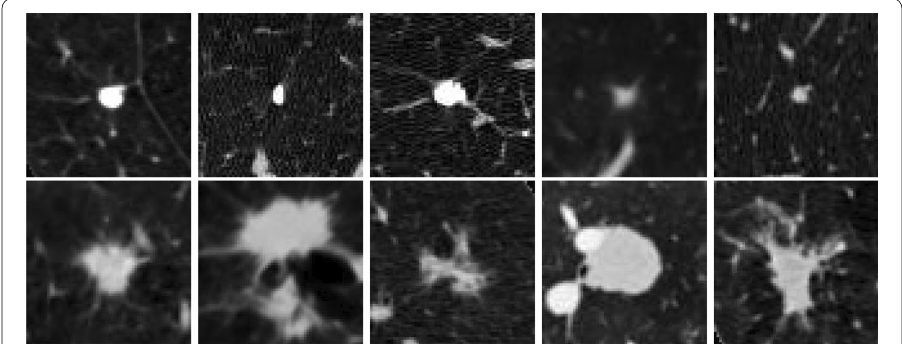
Fig. 17 Some samples of benign (the first row) and malignant (the second row) pulmonary nodules in classification results